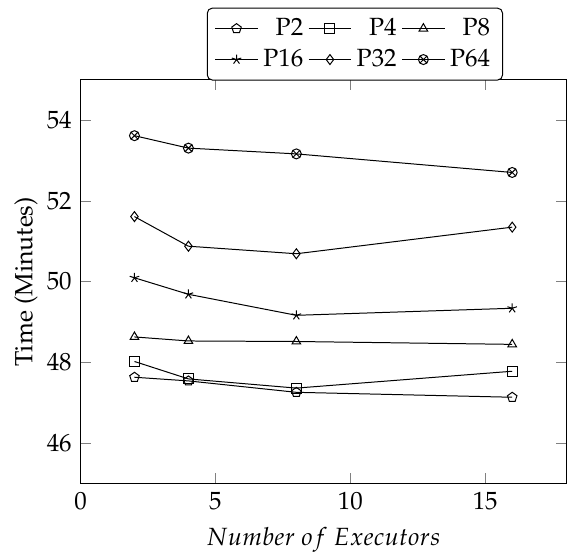
Figure 11. Performance against the # of